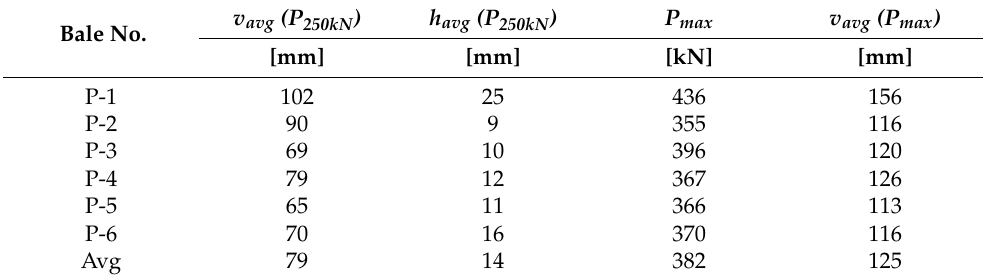
P-6 70 Avg 79 382